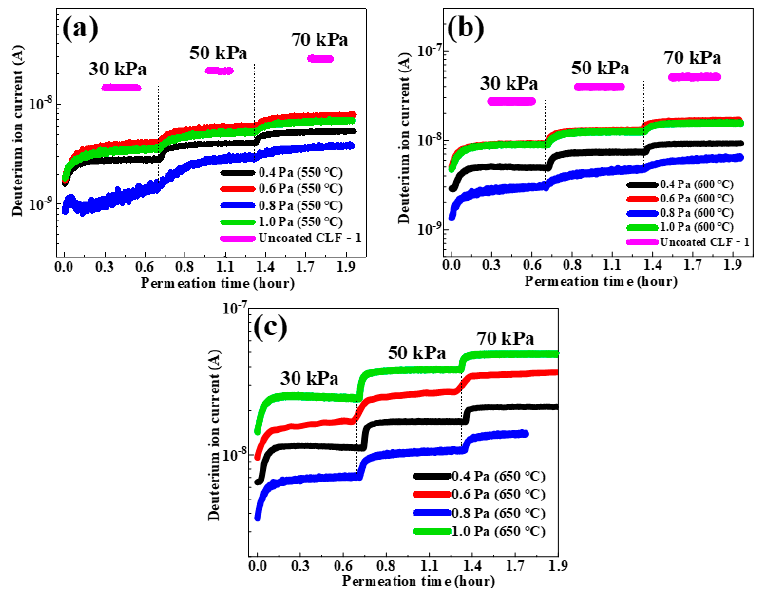
Figure 5. Deuterium ion current–time curves of Pd films at different temperatures and driving pressures: ( a ) 550 ◦ C, 30–70 kPa; ( b ) 600 ◦ C, 30–70 kPa; ( c ) 650 ◦ C, 30–70 kPa.